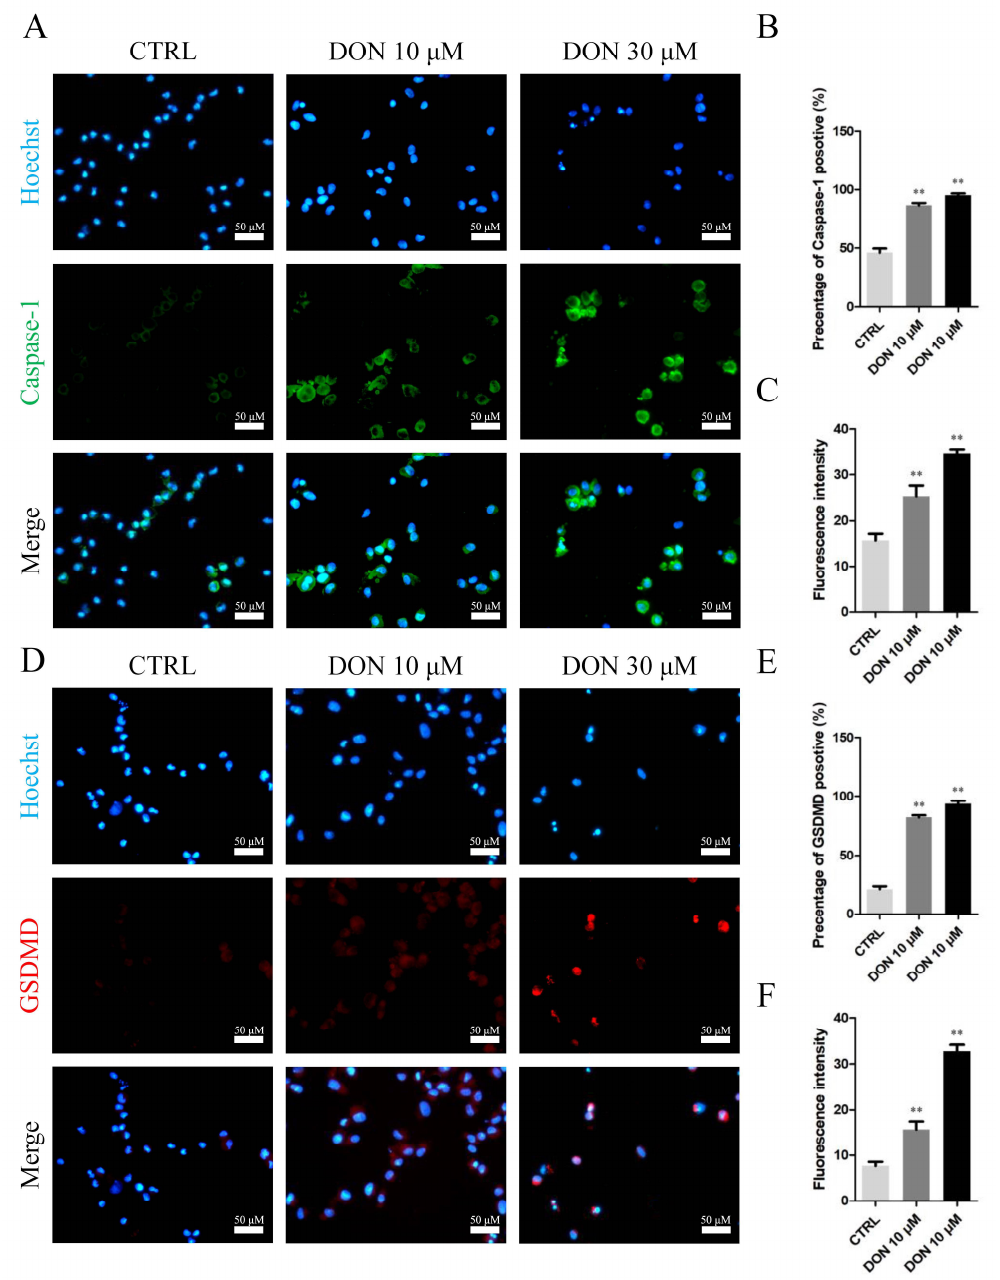
Figure 5. Immunofluorescence assay probing the expression of SC phosphor- Caspase1 ( A ) and GSDMD ( D ) proteins in the DON treatment groups. The percentages of positive cells ( B , E ) and fluorescence intensity ( C , F ) were analysed. Bar indicates 50 μm. Data are presented as the means ± SD. ** p < 0.01.